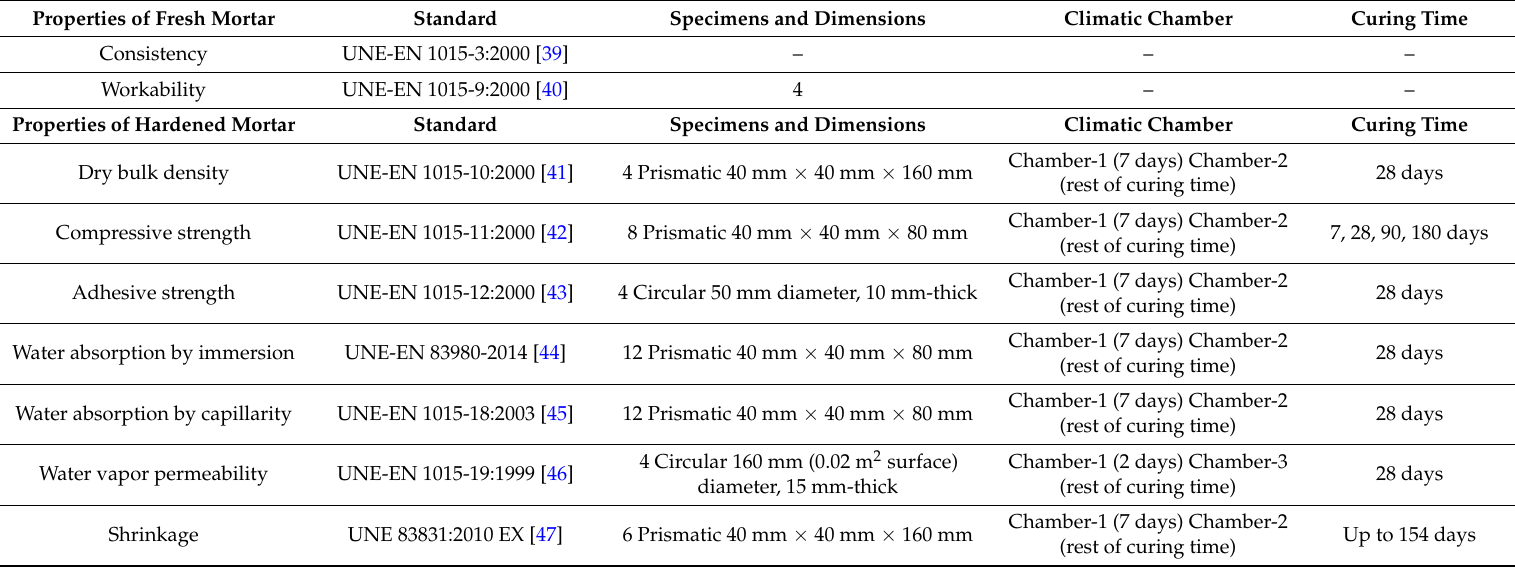
Table 6. Mortar characterization test.